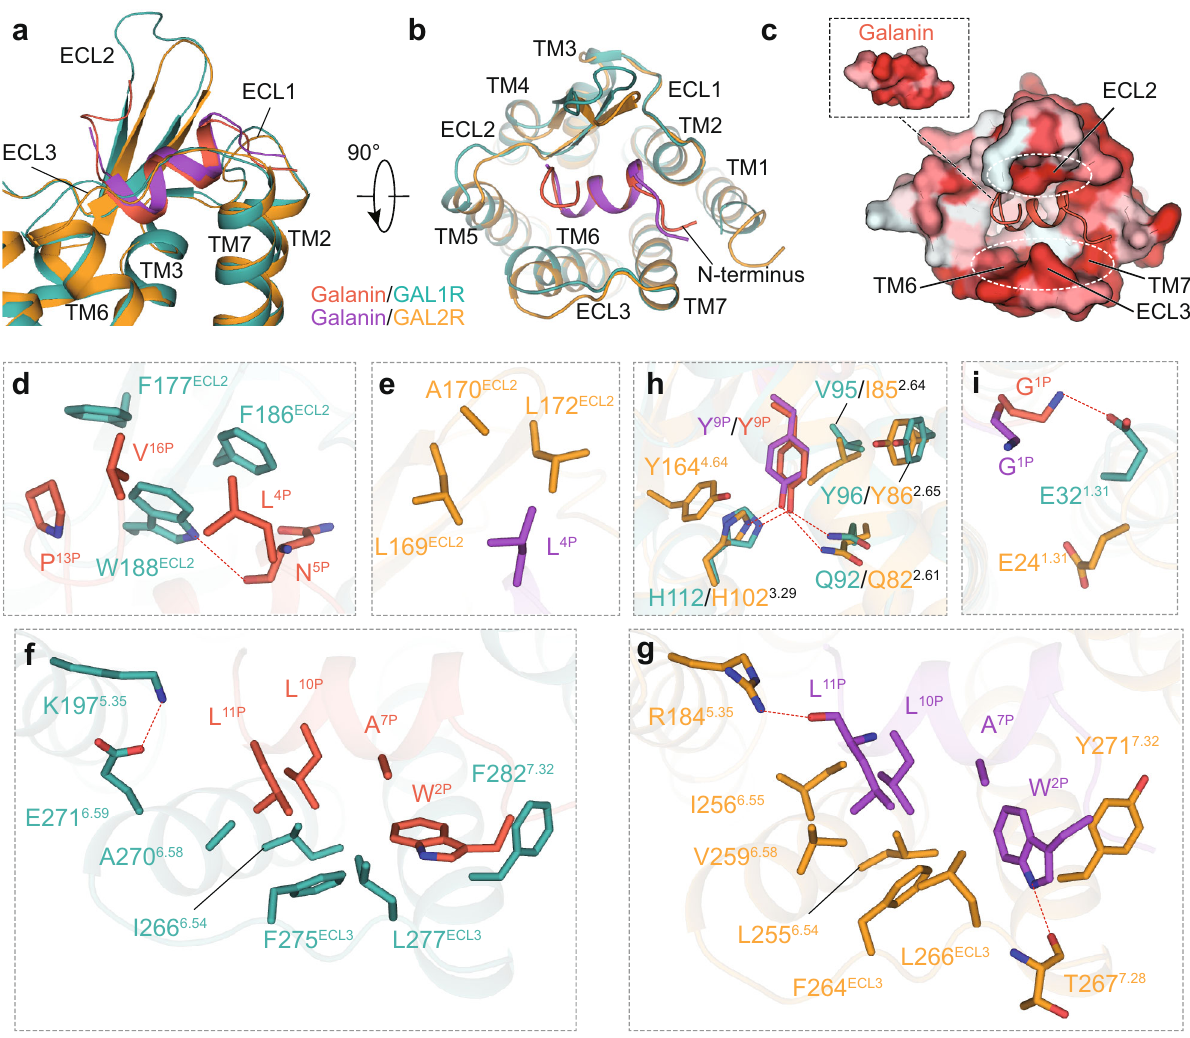
Fig. 3 Recognition mechanism of GAL1R and GAL2R by galanin. The overall binding pose of galanin in GAL1R and GAL2R in the side view ( a ) and extracellular view ( b ). c Two hydrophobic patches at the extracellular surface of the GAL1R binding pocket sandwich with galanin. Two hydrophobic patches are highlighted as white dashed ovals. Receptor surface is colored by hydrophobicity, from white for hydrophilic to red for hydrophobic. Detailed interactions between galanin and the hydrophobic patch in ECL2 of GAL1R ( d ) and GAL2R ( e ). The H-bond is shown as a red dashed line. Detailed interactions between galanin and the hydrophobic patch in TM6-ECL3-TM7 of GAL1R ( f ) and GAL2R ( g ). h Interactions between Y 9P and residues of two galanin receptors. i Detailed interactions between G 1P of galanin and two galanin